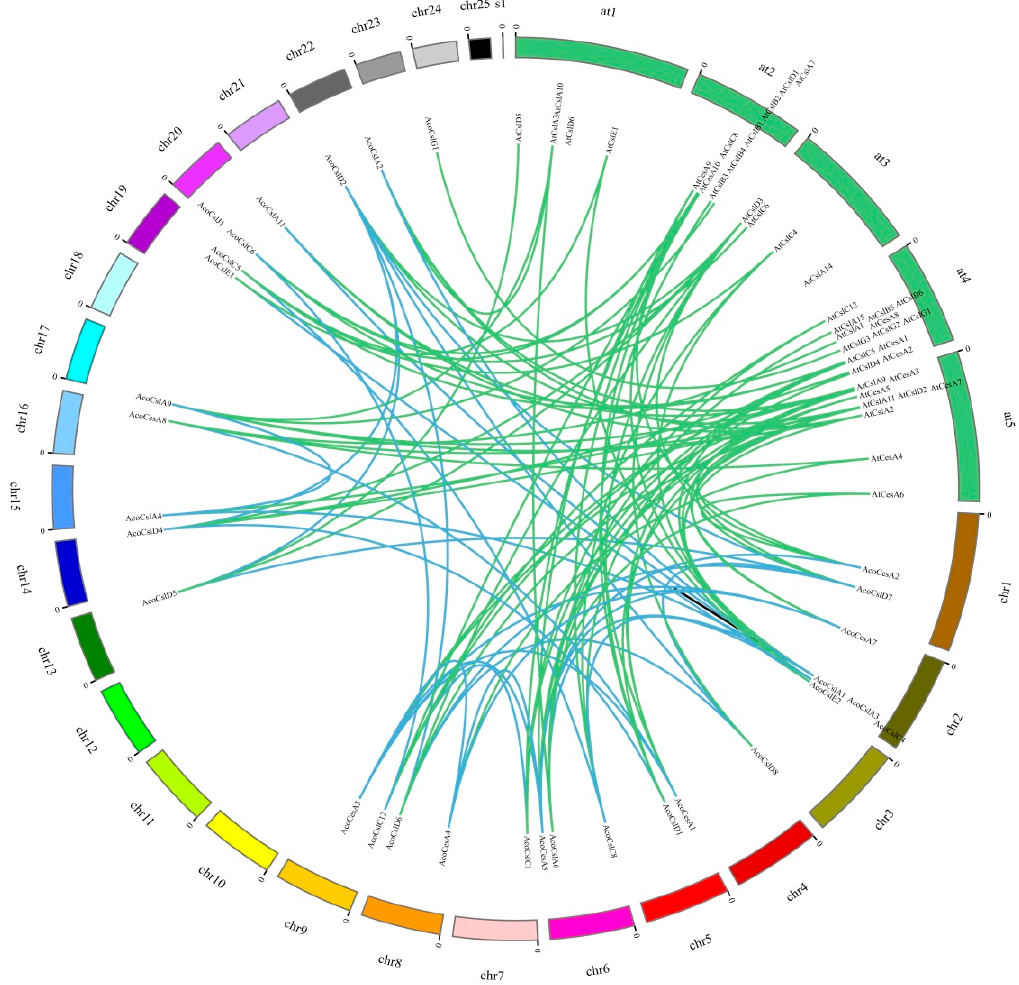
Figure 4. Synteny analysis between pineapple and Arabidopsis Ces/Csl genes. Chromosomes and scaffolds of pineapple and Arabidopsis are shown in different colors and in partial circles. Colored curves indicate the syntenic relationships between pineapple and Arabidopsis Ces/Csl genes. The prefix ‘Aco’ indicates Ananas comosus .